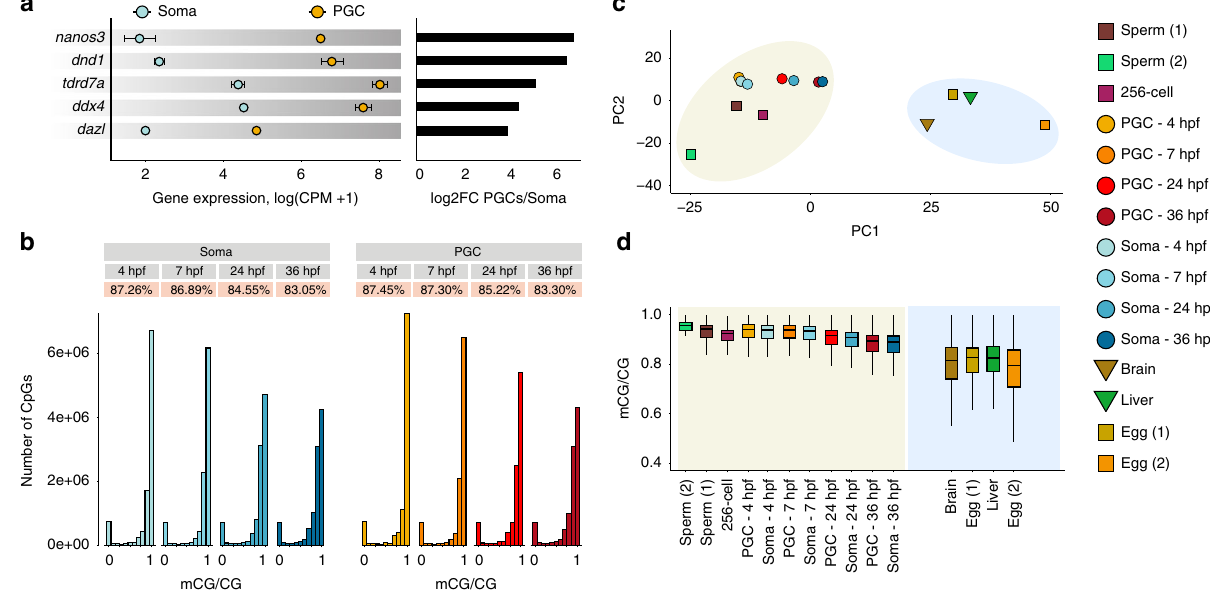
Fig. 2 Zebra fi sh retains paternal epigenetic memory in primordial germ cells (PGCs). a Gene expression log(CPM + 1) and average enrichment levels of key germline markers in PGCs and somatic cells. Error bars represent standard error (SE), n = 2 biologically independent replicates. b Histograms of 5- methylcytosine (5mC) levels of single CpG sites in PGCs and somatic cells at four developmental stages. c Principal component analysis (PCA) of whole- genome bisul fi te sequencing (WGBS) methylomes corresponding to PGCs and somatic cells at 4, 7, 24 and 36 hpf, and sperm, oocyte, liver and brain adult tissues (10 kb non-overlapping genomic bins). d Boxplots of genomic 5mC levels (10 kb non-overlapping genomic bins) in embryonic and adult somatic and germ cells. The boxes show the interquartile range (IQR) around the median. The upper and lower whiskers extend from the hinge to the largest and smallest value, respectively, no further than 1.5